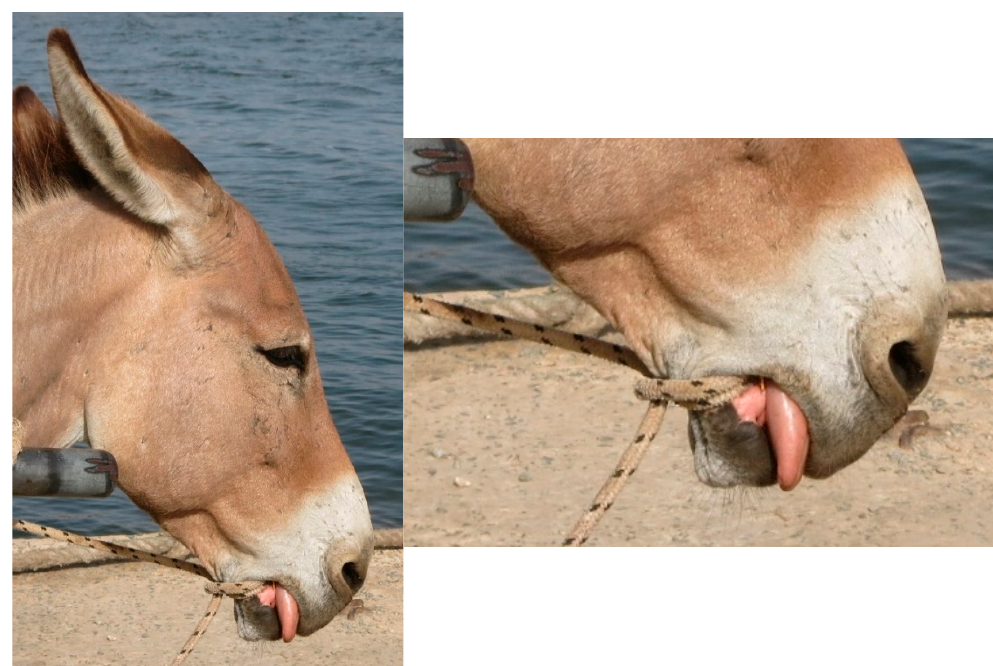
Figure 3. Use of rope around lower jaw in place of a bit in a cart donkey in Senegal.